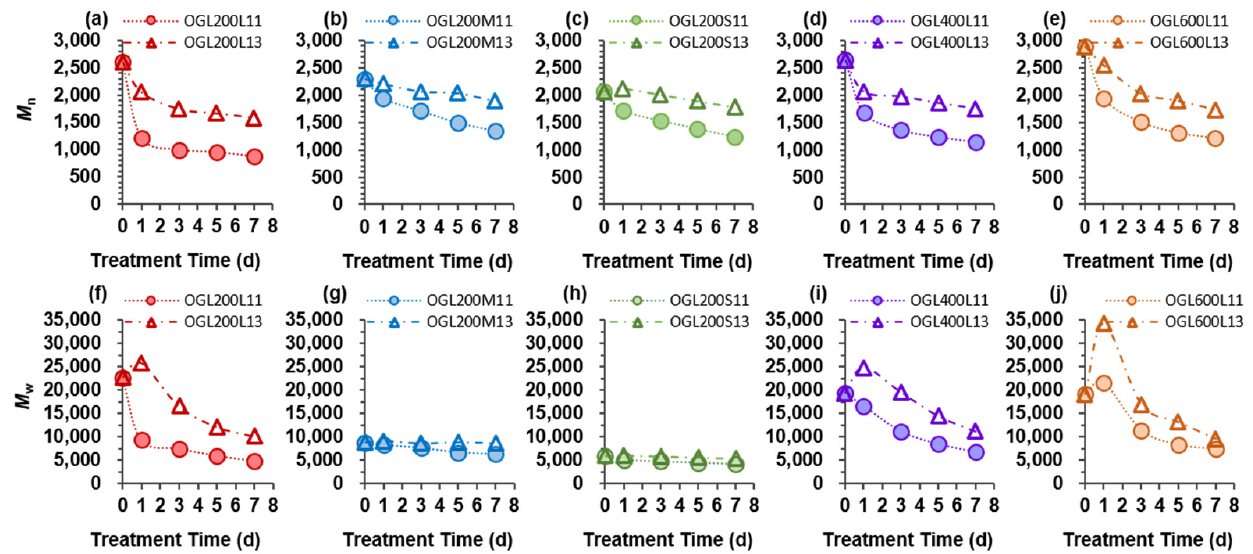
Figure 3. Molecular weight, M n (a – e) and M w (f – j) of OGLs as a function of H 2 O 2 treatment time. (a,f) OGL200L series, (b,g) OGL200M series, (c,h) OGL200S series, (d,i) OGL400L series, and (e,j) OGL600L series were obtained through the room-temperature H 2 O 2 treatment of GLs with H 2 O 2 /GL 1:1 and 1:3 mass ratios.